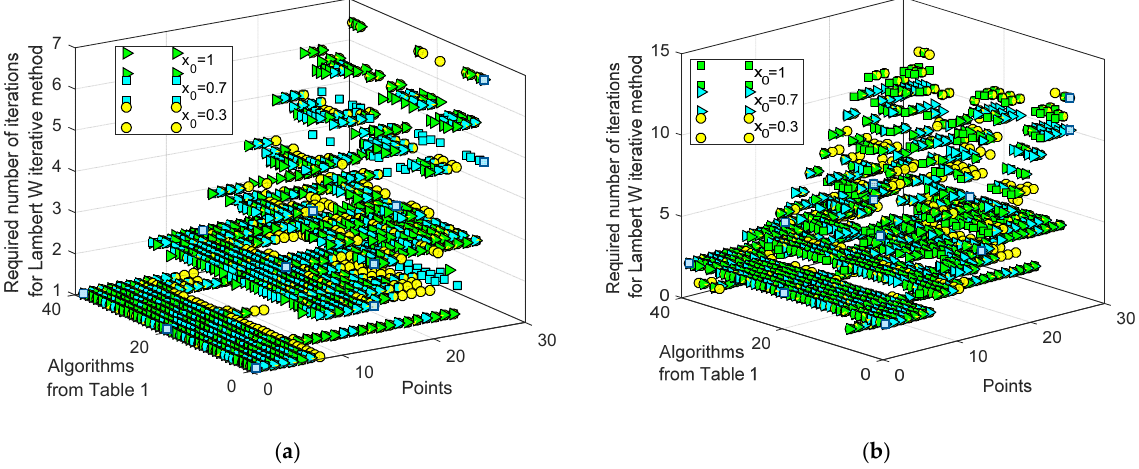
Figure 7. Required number of iterations for all voltage values with different stopping criteria using ILWF: ( a ) 10 − 5 ; ( b ) 10 − 10 .